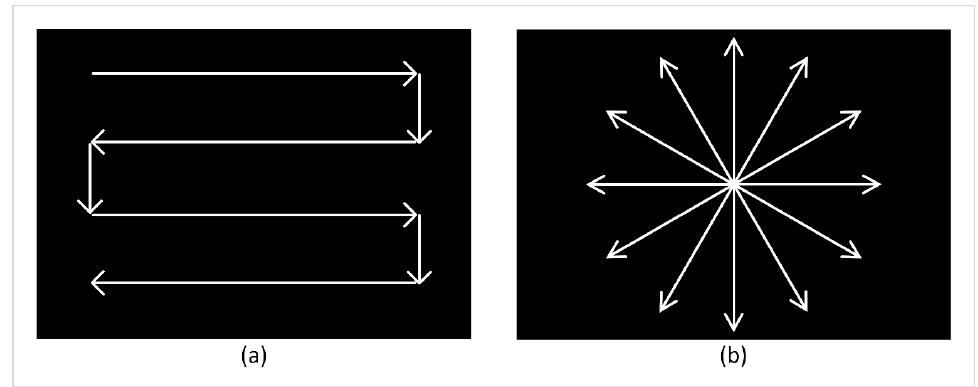
Figure 1. Visual representation of the left – right scanning pattern ( a ) and the radial scanning pattern ( b ) that participants were asked to follow during the visual tasks.